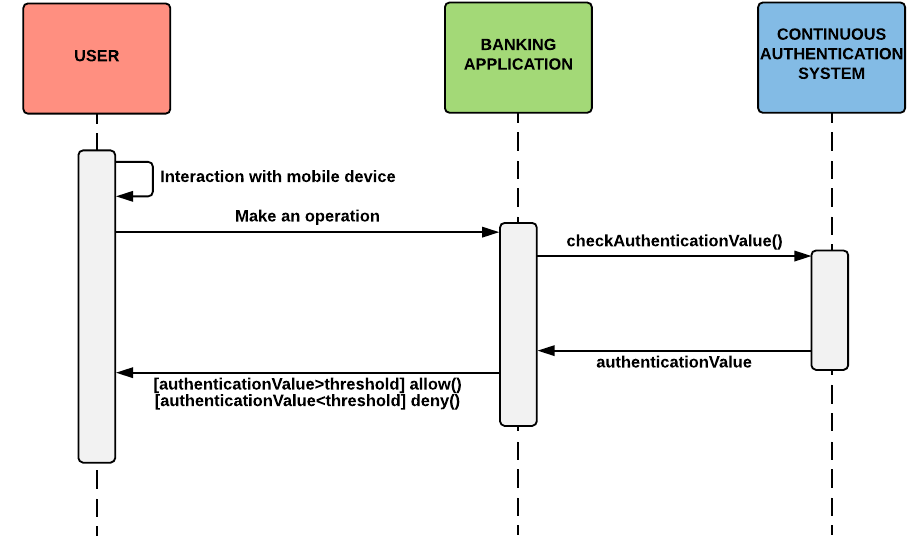
Figure 11. Flow diagram of the use case.